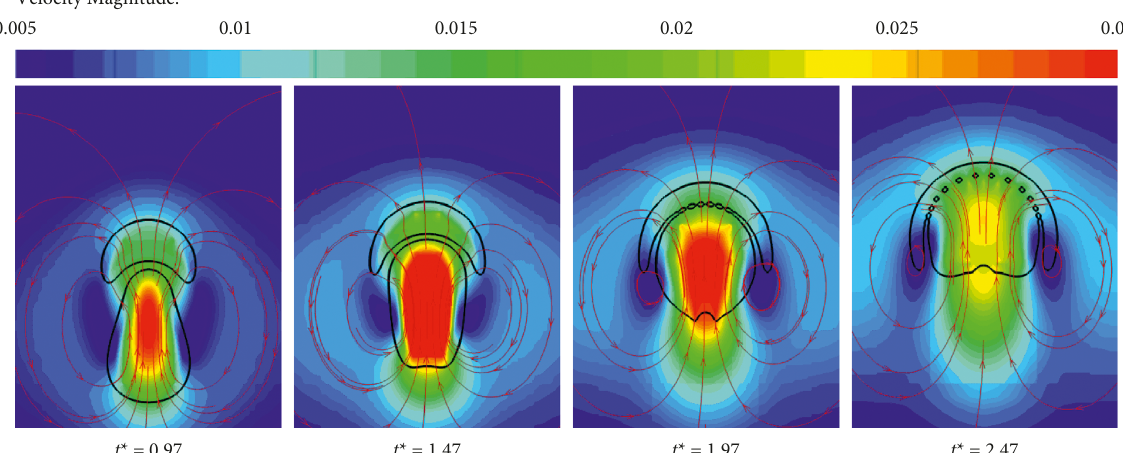
Figure 4: Coalescence process between two bubbles and corresponding flow field at Bo � 50, Ar � 10, ρ